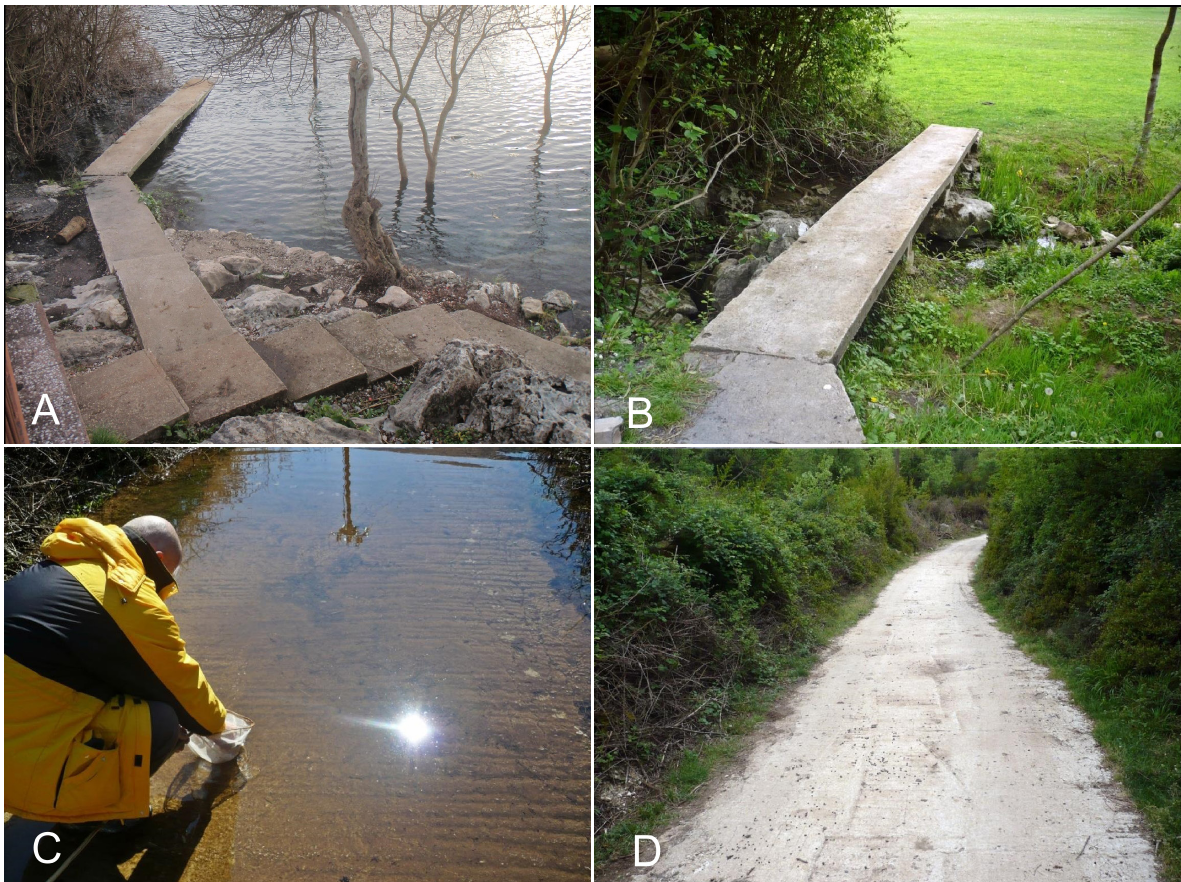
Fig. 5. The major spawning ground of the Neretva nase, Chondrostoma knerii , in the Hutovo Blato wetland; conditions of high water ( A , C ) and conditions of dry years ( B , D ); photo by Branko Glamuzina (A and C , March 2013; B